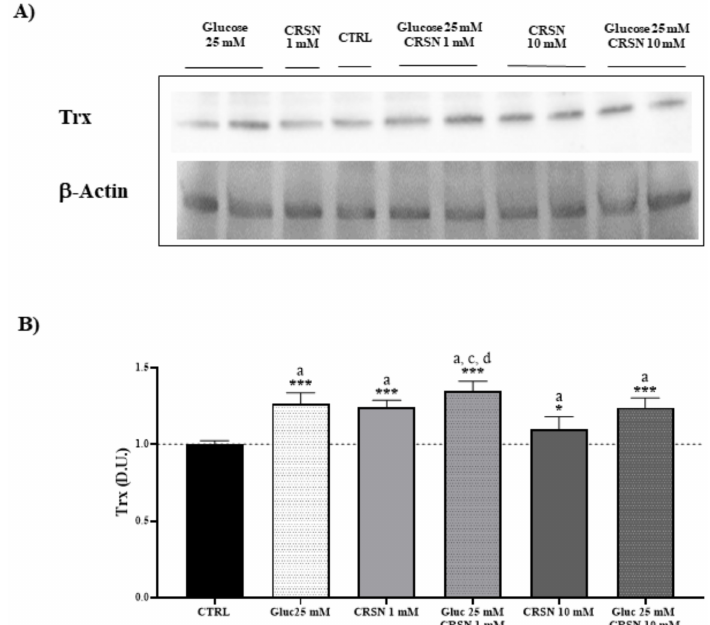
Figure 4. Cellular thioredoxin (Trx) protein concentration (normalized to untreated cells) significantly increased in murine immortalized podocytes under glucose stress (25 mM; p = 4.1 × 10 − 3 ) or under carnosine addition (1 mM; p = 5.2 × 10 − 4 ). Coincubation with carnosine (1 mM) and glucose (25 mM) induced further upregulation of Trx protein concentration compared to carnosine alone ( p = 0.02) or control ( p = 3.8 × 10 − 6 ), but not compared to glucose alone ( p = 0.1), determined by western blotting ( A ) and quantified with an imaging software normalized to respective β -actin concentrations ( B ). Note: n = 5, a = significant increase vs. control, c = significant increase vs. carnosine (1 mM), d = significant increase vs. glucose (25 mM) + carnosine (10 mM), * p < 0.05, *** p <